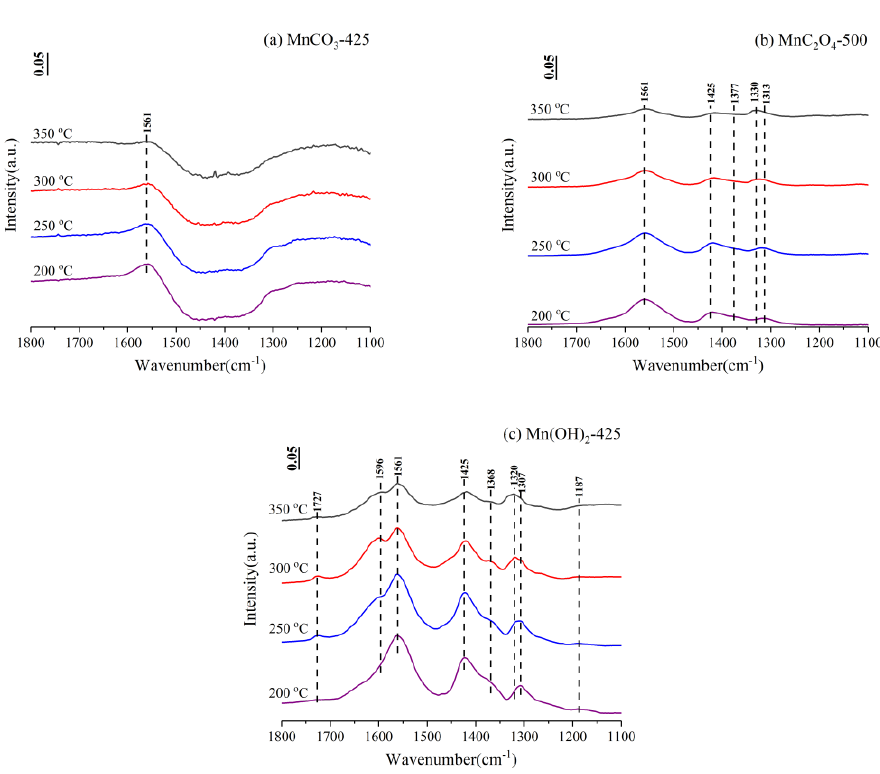
Figure 9. In-situ FTIR spectra of the ( a ) MnCO 3 -425 ( b ) MnC 2 O 4 -500 ( c ) Mn(OH) 2 -425 catalysts collected at 200 °C during oxidation at 30 min in a 1000 ppm benzene/20 vol% O 2 /N 2 stream followed by the temperature programmed to 250 °C, 300 °C and 350 °C.